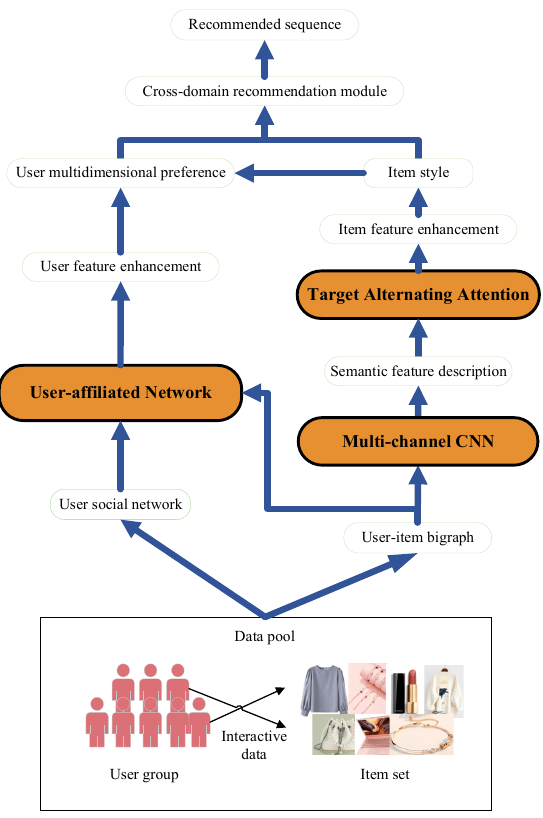
Figure 1. The overall framework of TAUA.